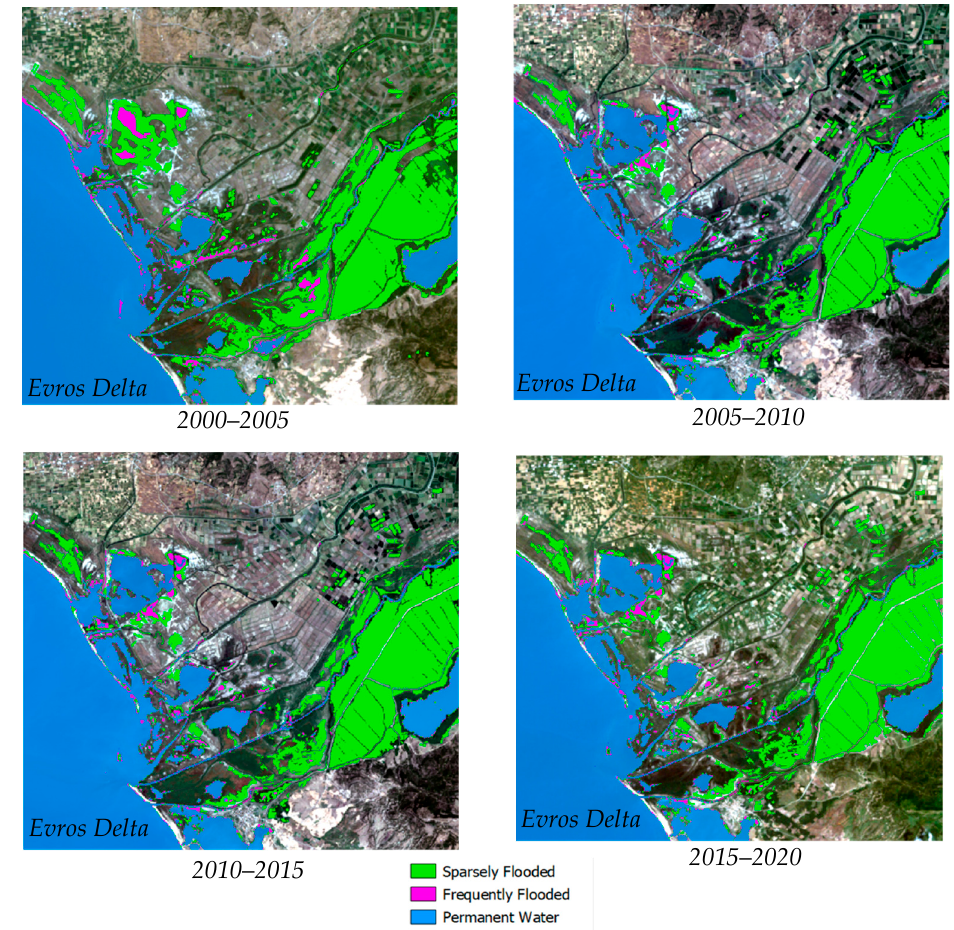
Figure 14. Average 5-Year flood probability map samples for Evros river delta.